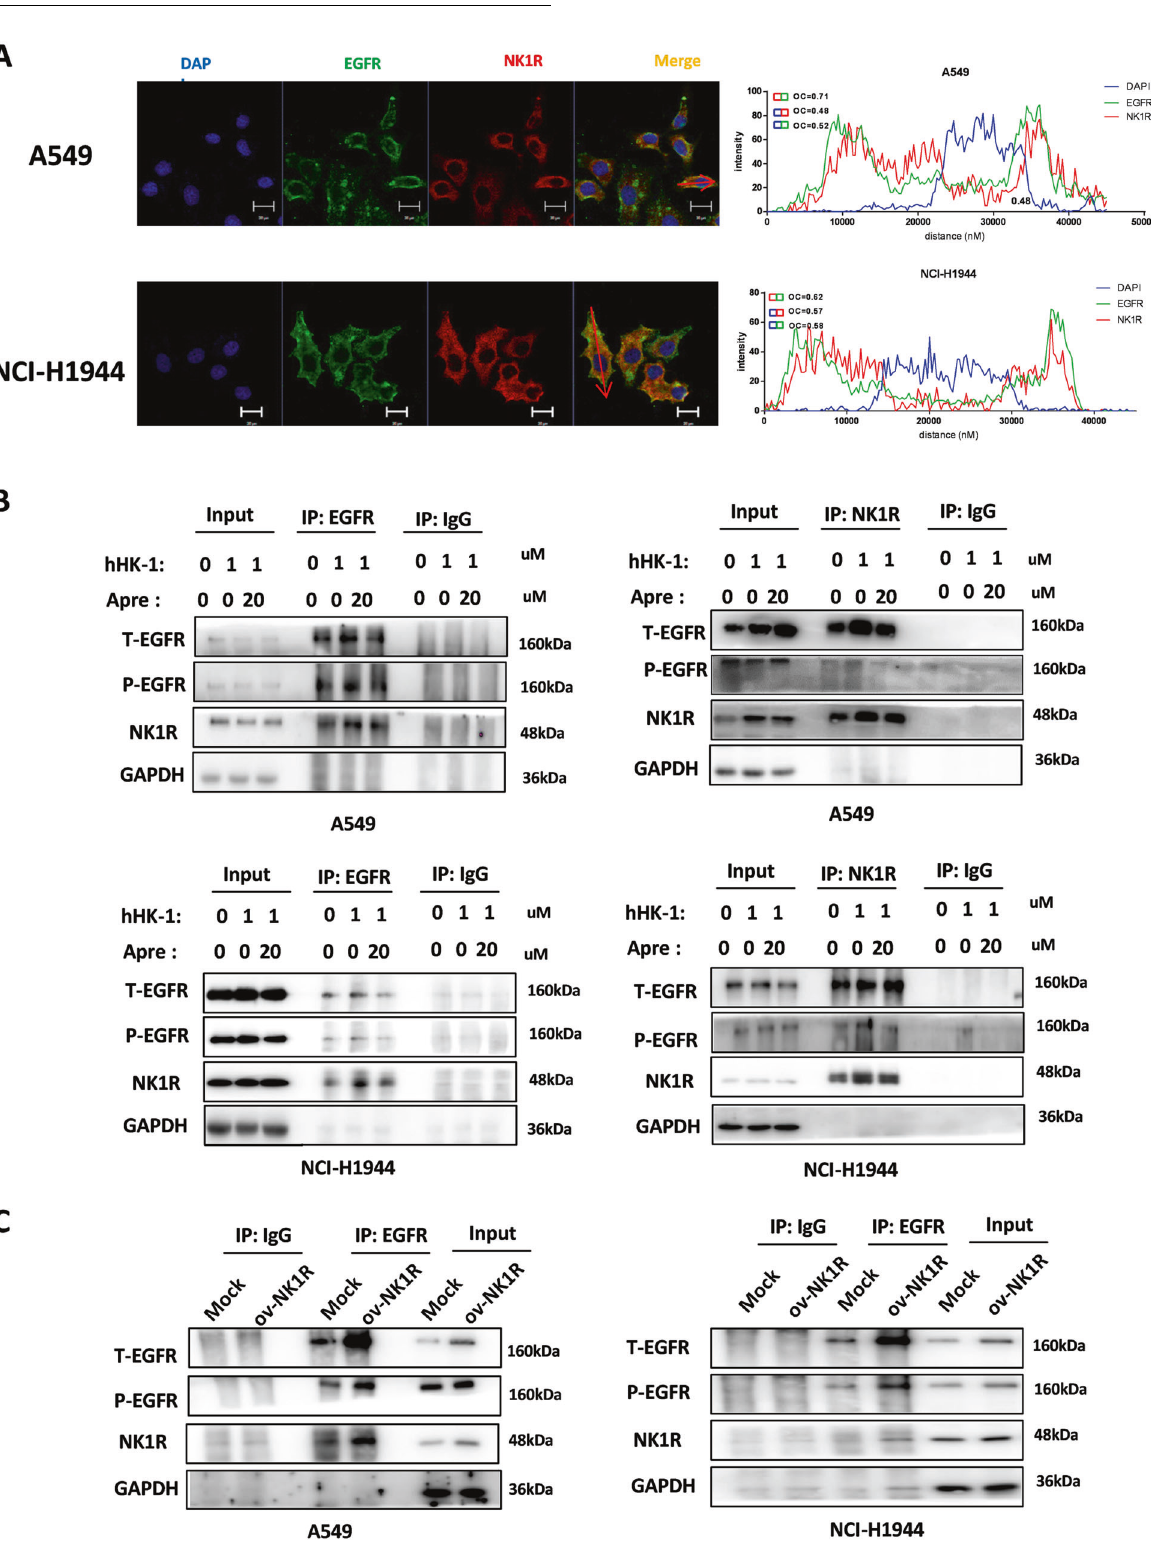
Cell Death and Disease (2022)